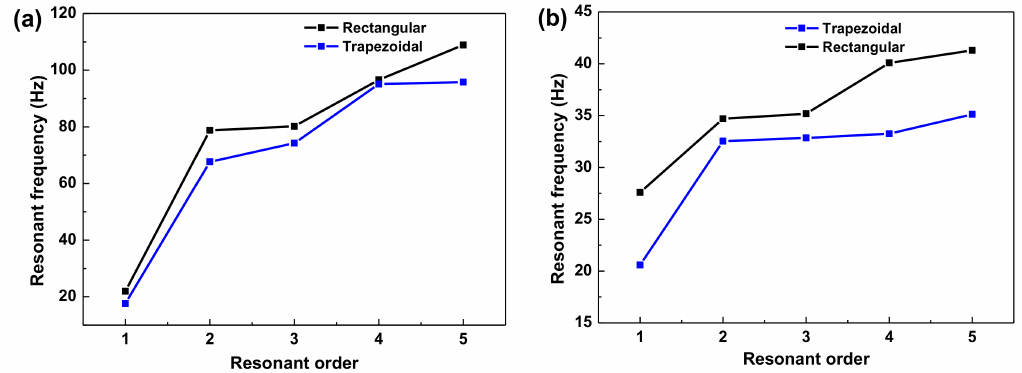
Figure 7. Resonant frequency of Case 1-based ( a ) and Case 2-based ( b )